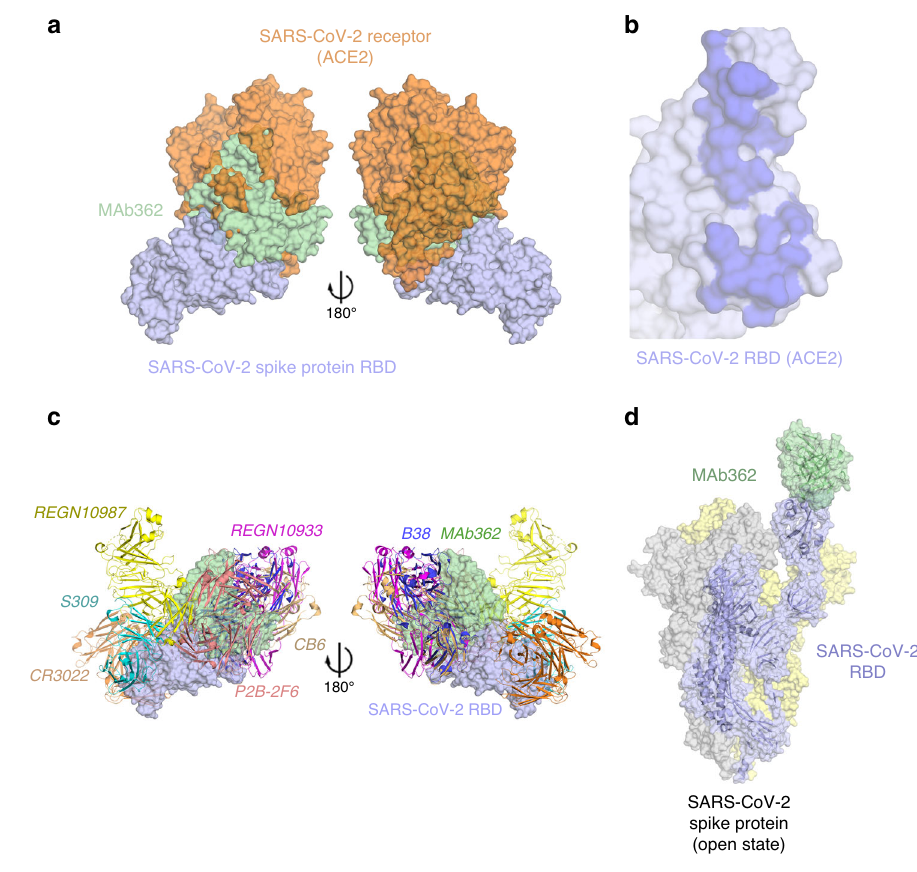
Fig. 3 Predicted MAb362 structural epitope. a Superposition of the space fi lling molecular model of MAb362 (green) complex on the crystal structure of the complex of ACE2 (orange) -SARS-CoV-2 RBD (violet) (6VW1 23 ) two views are rotated 180°. b The binding interface on SARS-CoV-2 RBD with ACE2 calculated from the co-crystal structure of the complex. The binding interface shown as darker shade is de fi ned as having vdW contacts great than − 0.5 kcal mol − 1 . c Positioning of MAb362 on SARS-CoV-2 RBD (violet) relative to the binding of other currently published SARS-CoV-2 RBD-neutralizing antibodies: CR3022 (PDB: 6W41 46 ; orange); S309 (PDB: 6WPT 16 ; cyan); REGN10933 and REGN10987 (PDB: 6XDG 25 ; magenta and yellow); P2B-2F6 (PDB: 7BWJ 26 ; salmon); CB6 (PDB: 7C01 27 ; wheat) and B38 (PDB: 7BZ5 28 ; blue). MAb362 recognized a unique epitope overlapping with the binding interface of ACE2. d Predicted MAb362 molecular model on the spike trimer in open conformation with one RBD domain exposed 6VYB 45